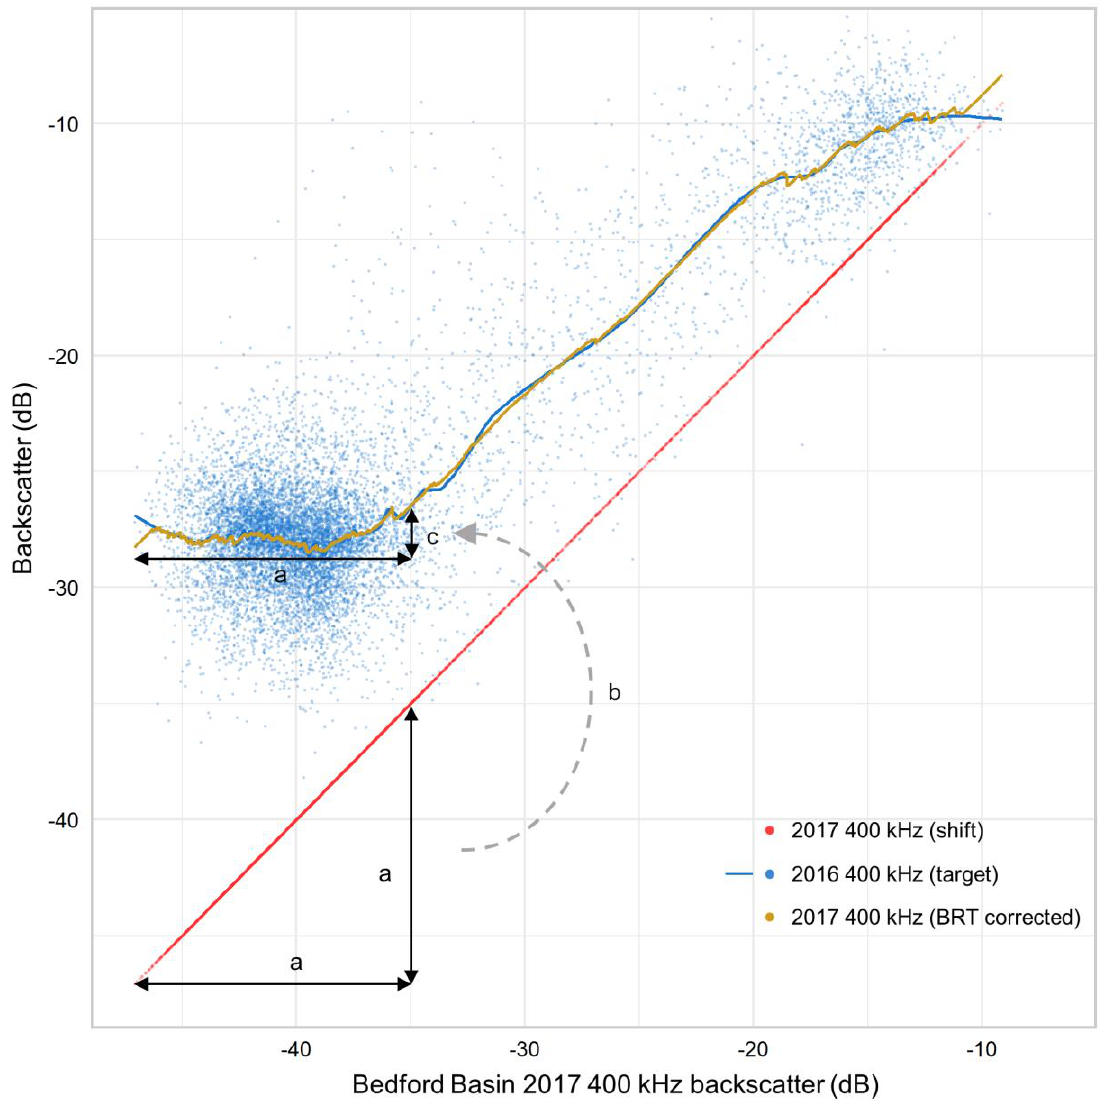
Figure A1. 2017 400 kHz Bedford Basin backscatter data on the x -axis, against 2017 (1:1 plot), 2016 (with LOESS curve), and BRT-corrected 2017 on the y -axis. Arrows delimit ( a ) the original ~12.5 dB range of backscatter values observed in the 2017 dataset, that were ( b ) compressed by the BRT bulk shift, to ( c ) a ~2 dB range based on values observed in the 2016 dataset.